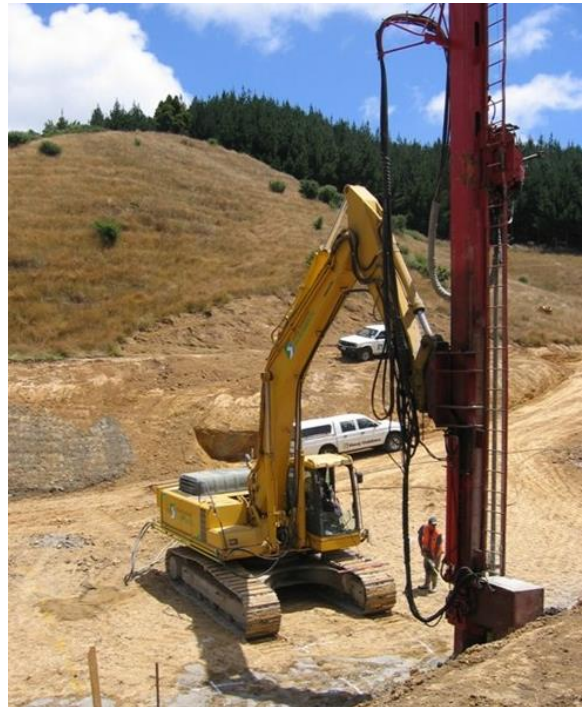
Figure 3. Vertical lime-cement columns – technology COLMIX [3].